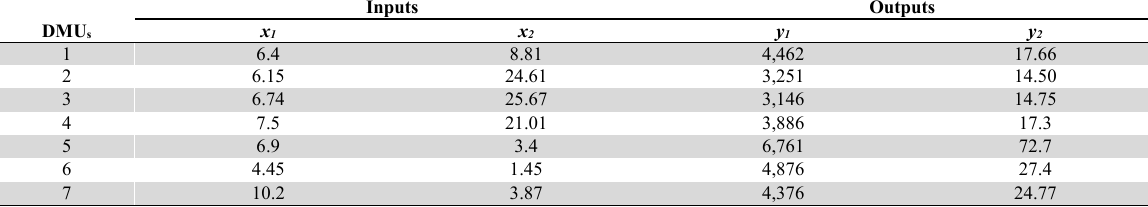
Data set of seven biomass fuel briquettes